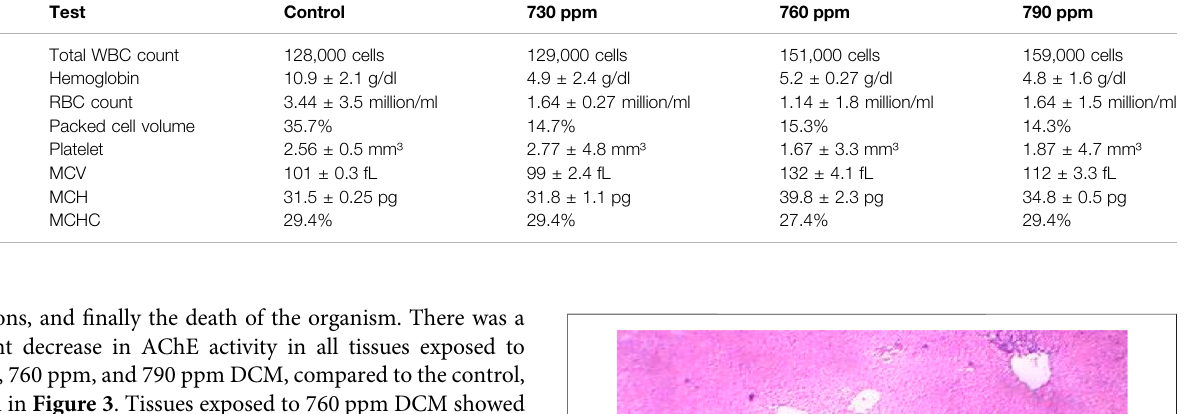
TABLE 1 | Hematological parameter of fi sh treated with different concentrations of dichloromethane. S No.